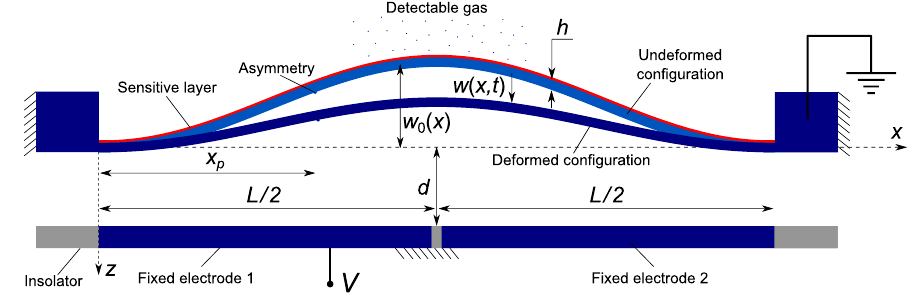
Figure 1. Schematic of the asymmetric arch beam gas